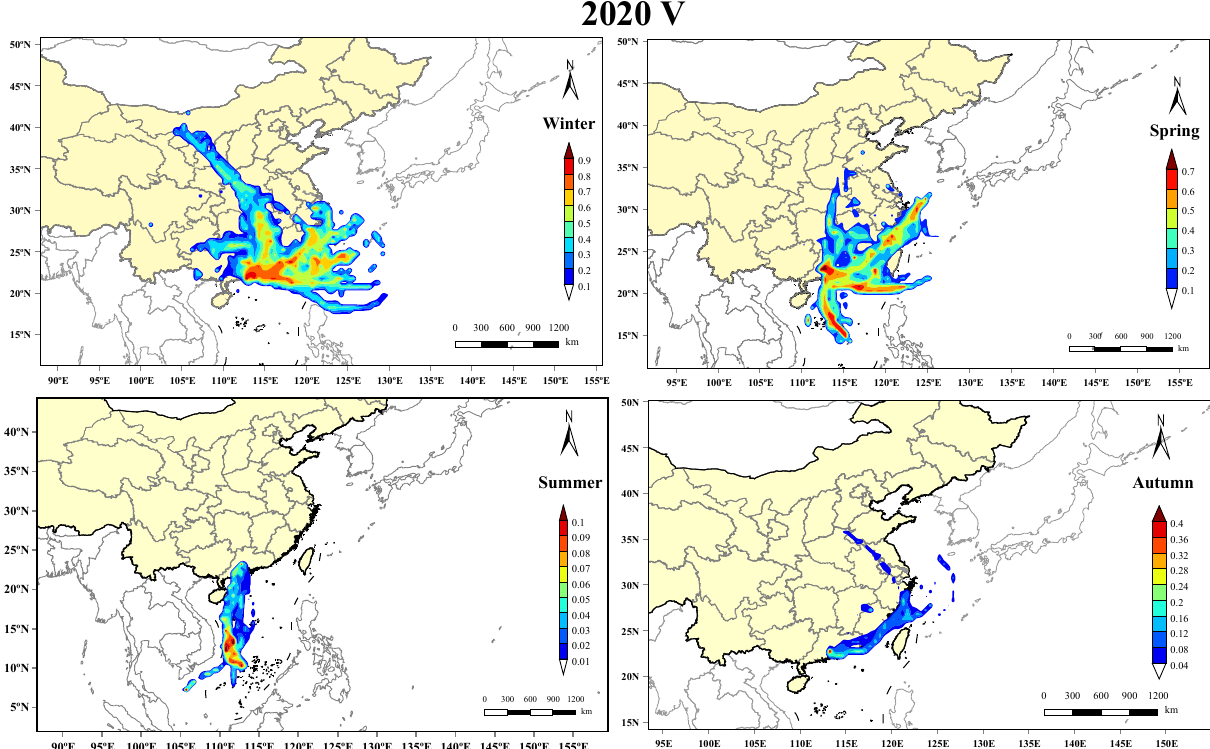
Figure 5. Potential source distribution of the particulate matter containing V in the four seasons in 2020. The hourly concentration of the particulate matter containing V was chosen as the standard threshold in the analysis. The colors in the legend represent the WPSCF values.